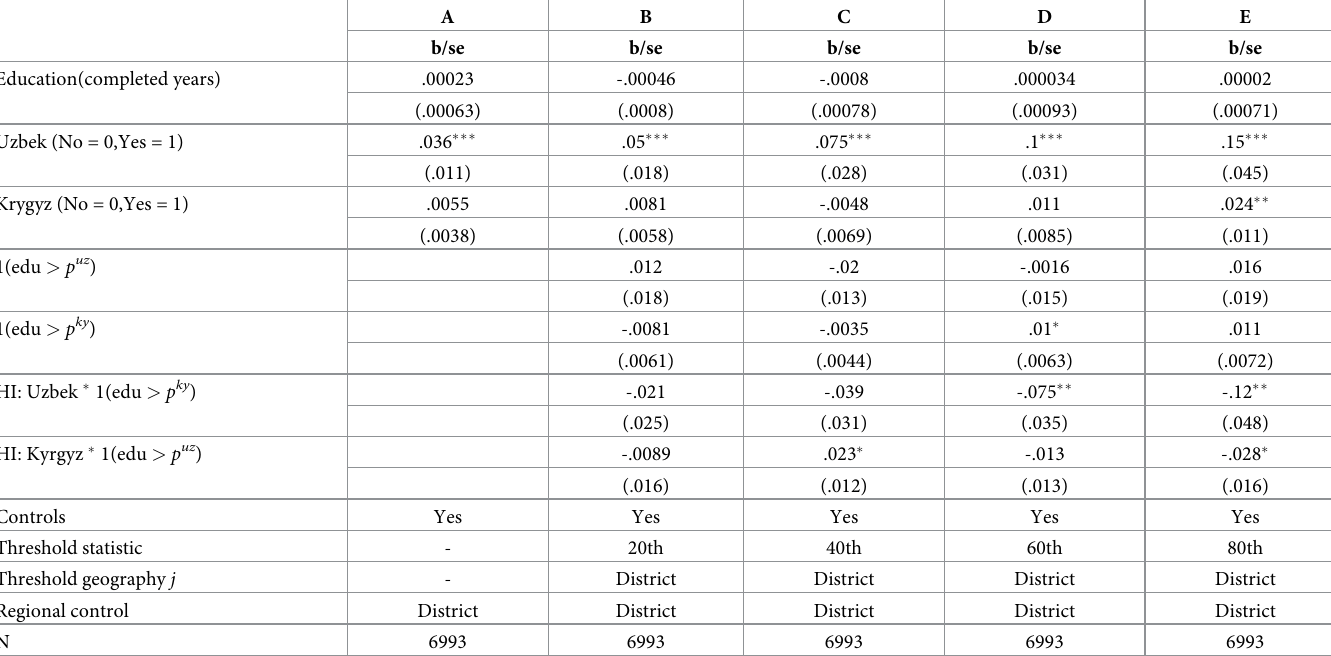
Table 7. Individual displacement and